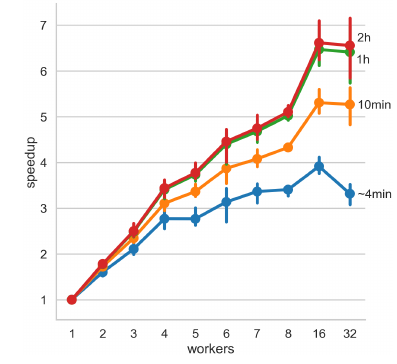
Figure 4: Big model benchmark results for performance models of longer total fitting run